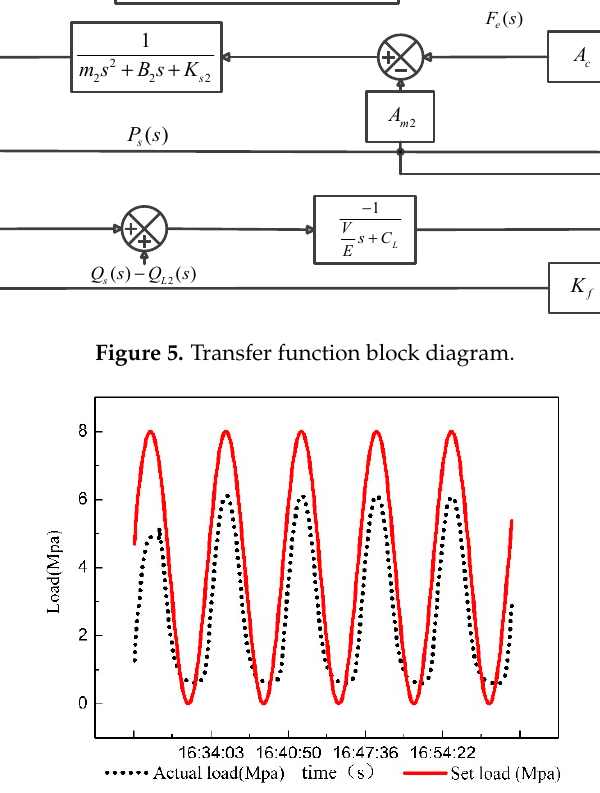
Figure 6. Dynamic curve diagram of real time data.